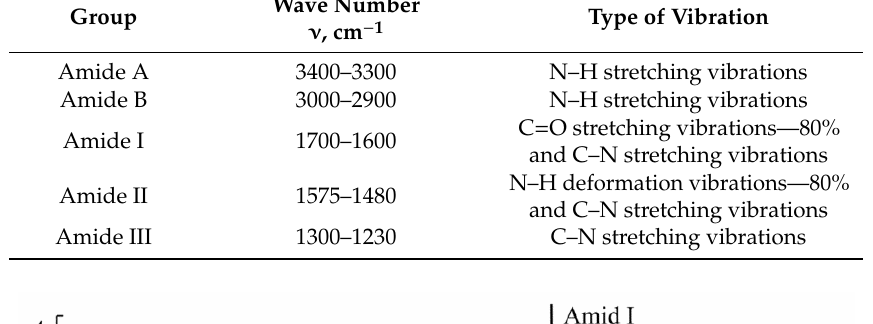
Table 4. Main absorption bands of the functional groups of gelatin [39,40].